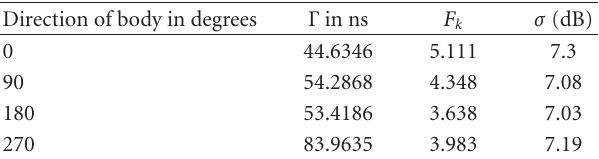
Table 2: Parameters of WBAN channel for di ff erent direction of